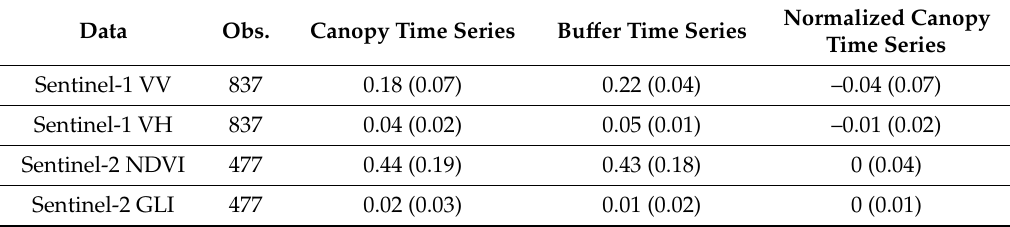
Table 1. Summary satellite data for eight focal Moabi crowns at Lop é NP. This table shows the overall mean (and standard deviation) of all crown-level means per satellite data source. Satellite data were sourced from the VV and VH synthetic aperture radar (SAR) bands of Sentinel-1 and from the normalized di ff erence vegetation index (NDVI) and the green leaf index (GLI) derived from Sentinel-2. ‘Canopy timeseries’ refers to the mean values extracted for each focal crown at each time step, ‘bu ff er time series’ refers to the mean values in the forest bu ff er surrounding each focal crown at each time step, and ‘normalized canopy time series’ refers to the di ff erence between the canopy and bu ff er values. Normalized Canopy Data Obs. Canopy Time Series Bu ff er Time Series Time Series Sentinel-1 VV 837 0.18 (0.07) 0.22 (0.04) –0.04 (0.07) 837 0.04